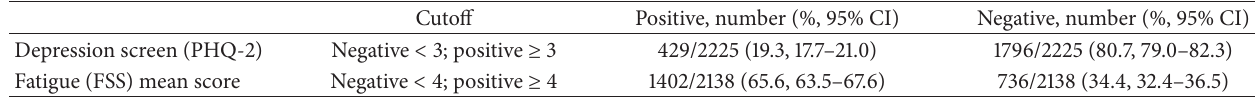
Table 8: Depression and fatigue screening.